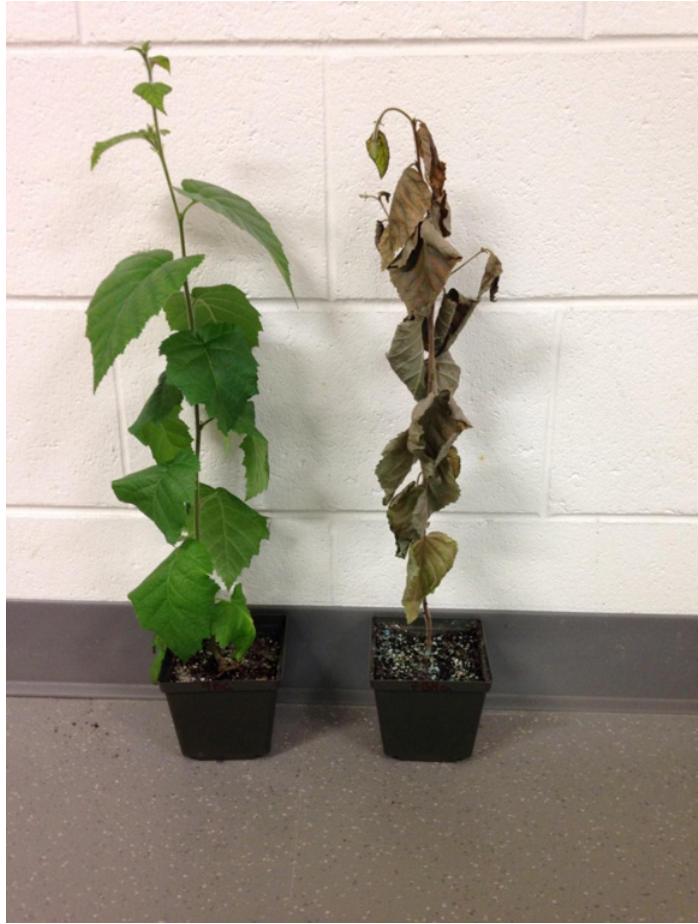
Fig 1. White birch ( Betula papyrifera ) from M2 populations treated with 1,600 mg/kg of nickel (Ni). Left and right plants are resistant (damage rating score of 1) and susceptible (damage rating score of 9) seven days after Ni treatment,